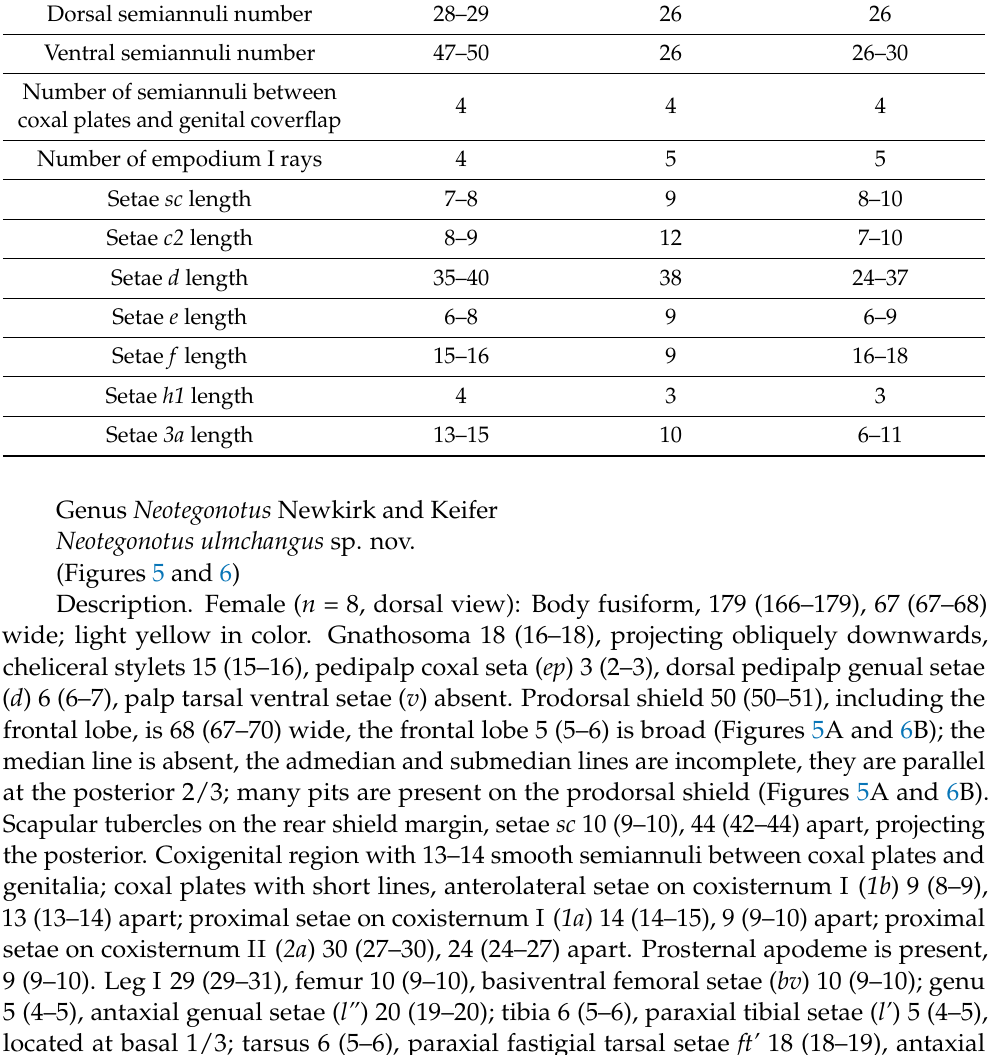
Table 1. Gross comparison of some important traits among Scolotosus ehretus sp. nov., S. centrolobii Flechtmann and Keifer, 2010, and S. hartfordi Flechtmann and de Queiroz, 2010.